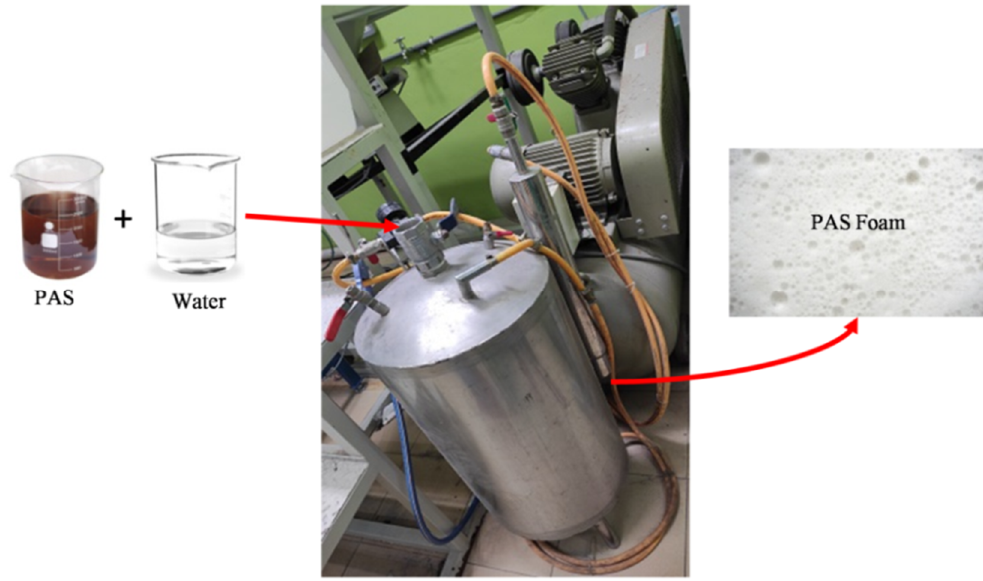
Figure 1. Preparation of PAS foam using a foam generator.